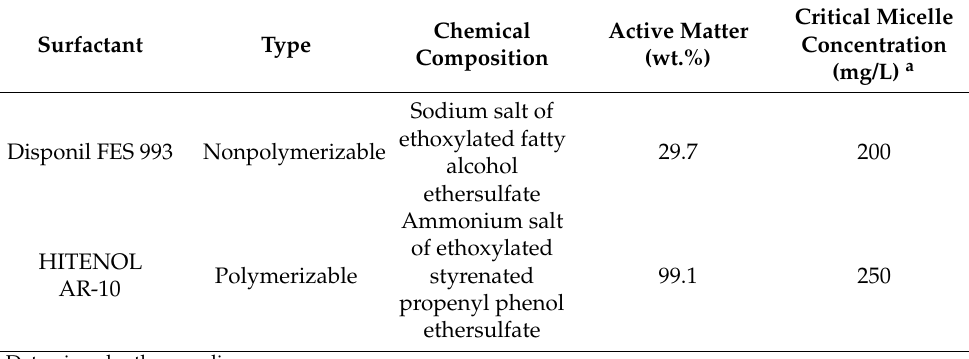
Table 1. Main characteristics of the used